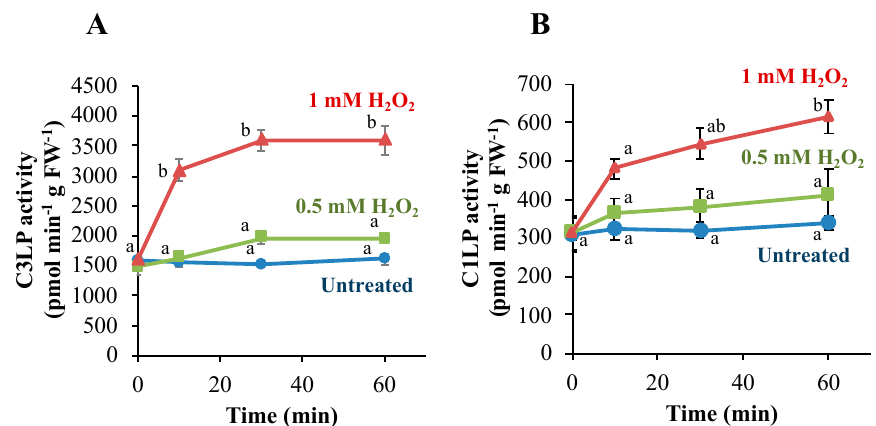
Figure 2. Activation of caspase-3-like protease (C3LP) ( A ) and caspase-1-like protease (C1LP) ( B ) in BY-2 cells after exposure to H 2 O 2 . Four-d cultured cells were treated with H 2 O 2 to 0.5 mM or 1 mM, as in Figure 1. Proteins was extracted from the cells as described in the Material and Methods section. The activity of C3LP ( A ) and C1LP ( B ) was measured with the respective substrates Ac-DEVD-AMC and Ac-YVAD-AMC, as in the Materials and Methods section. The data are the mean ± SE. Different letters represent significantly different values ( p < 0.05 on Tukey test).